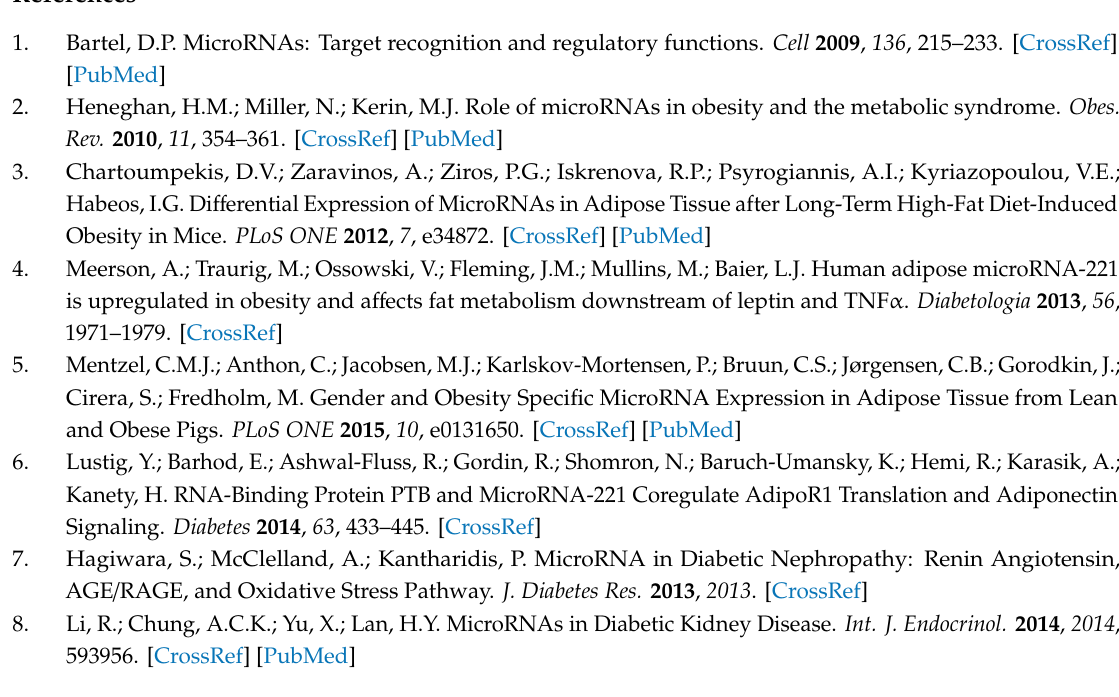
Table S1: Clinical measurements and ethnic / religious a ffi liations of the participant groups, Table S2: Multiple stepwise regression analysis to distinguish early vs. complicated DM using a panel of plasma